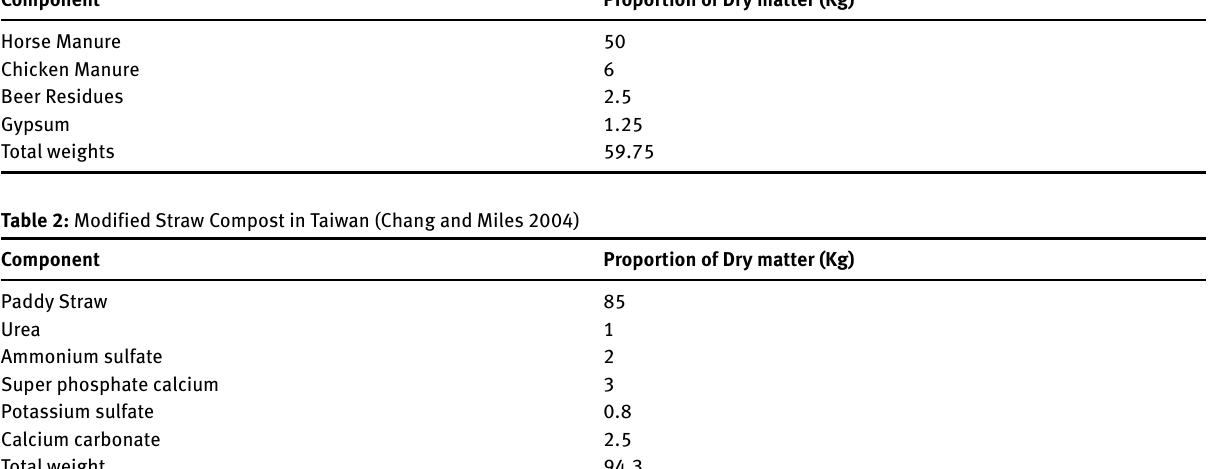
Table 1: Manure Compost in USA (Chang and Miles 2004) Component